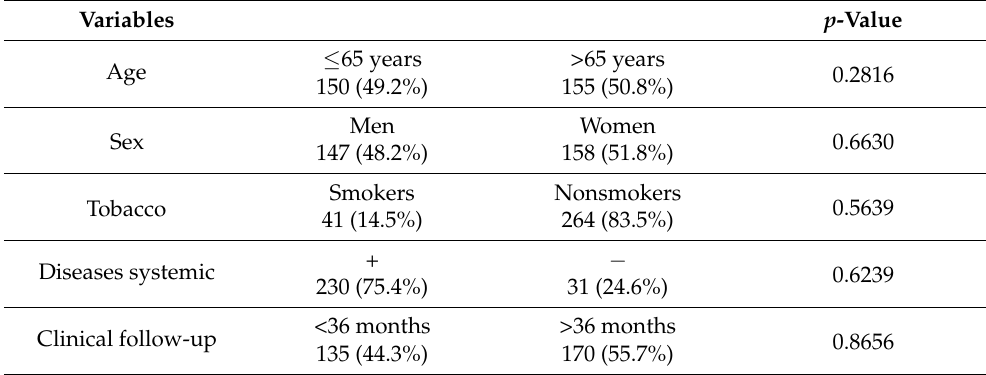
Table 3. Distribution of the number of splices ( n = 305).